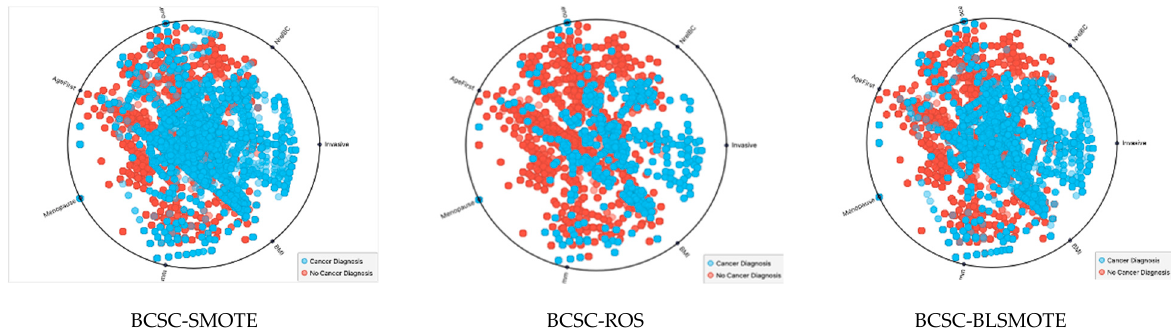
Figure 6. Effect of oversampling techniques on the BCSC dataset.